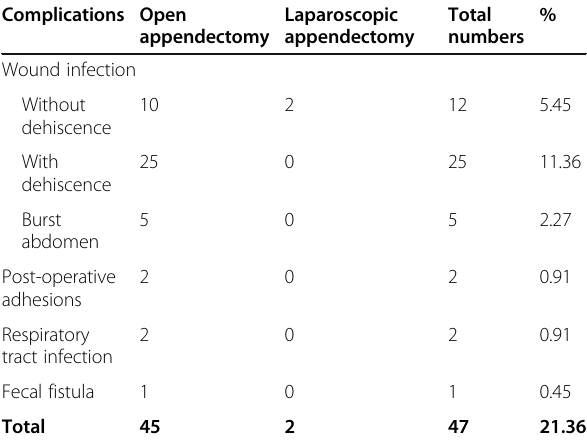
Table 4 Complications of early appendectomy for